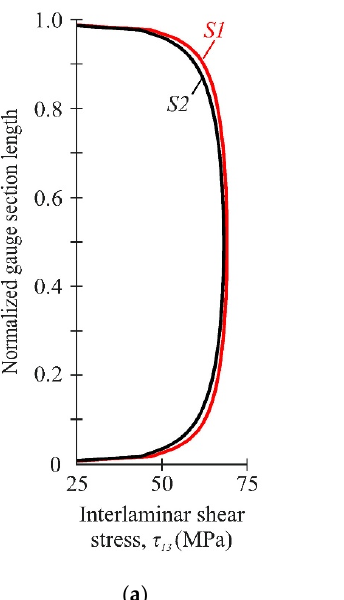
Figure 6. Distribution of interlaminar shear stresses ( a ), through-thickness stresses ( b ), and failure indexes NU-Daniel ( c ) between the notches at different specimen heights.